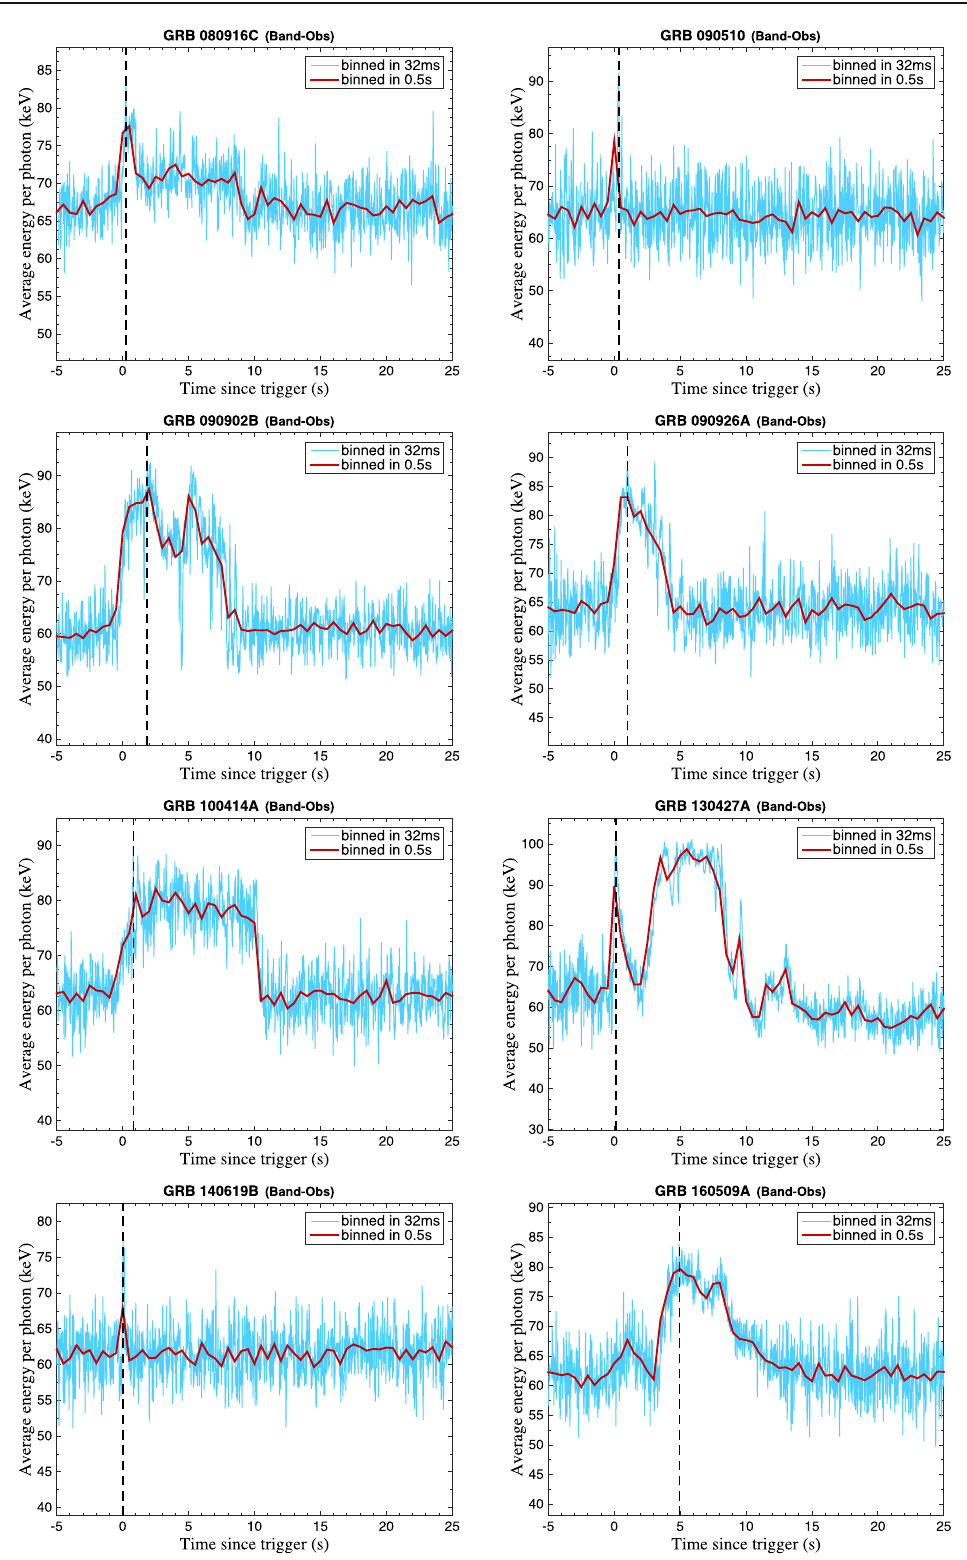
Fig. 5 The average energy curves in Band-Obs (average energy per photon in Band-Obs) of 8 GRBs. The x -axis is Δ t obs /( 1 + z ) . The thin curves (blue) are the energy curves binned in 0.032 s and the thick (red)